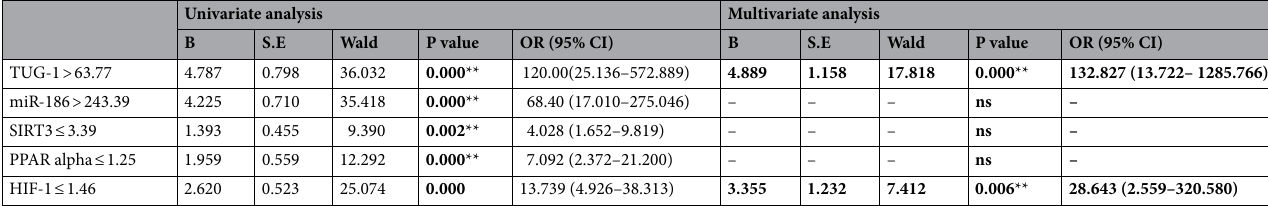
Table 5. Univariate and multivariate logistic regression analysis. ns non‑significant. Significant values are in [bold].